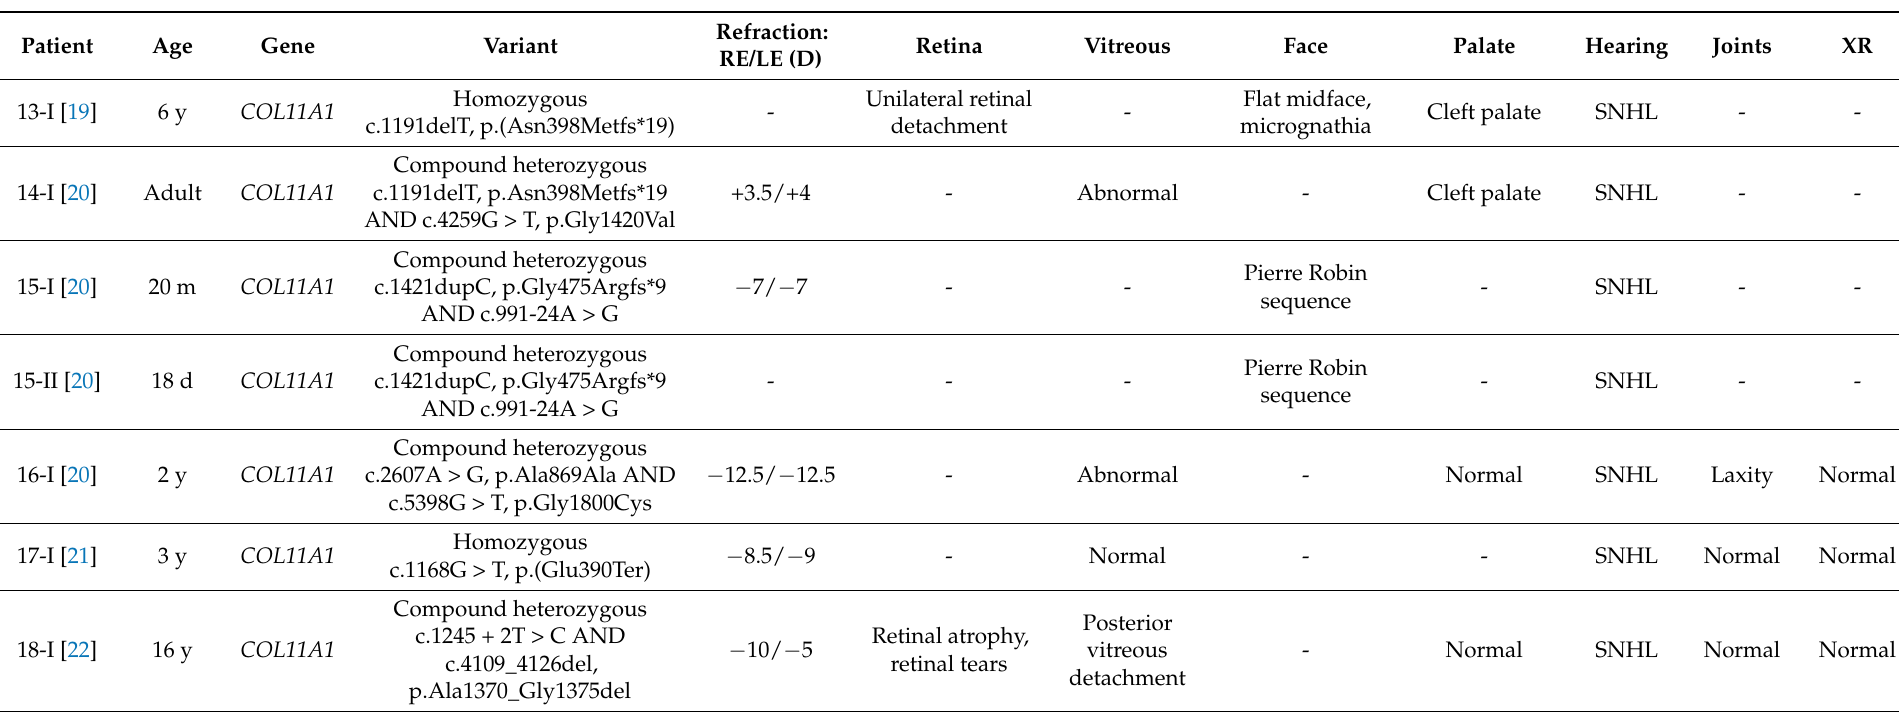
Table 4. Clinical features of patients with recessive pathogenic variants in COL11A1 . Variants are specified as homozygous or compound